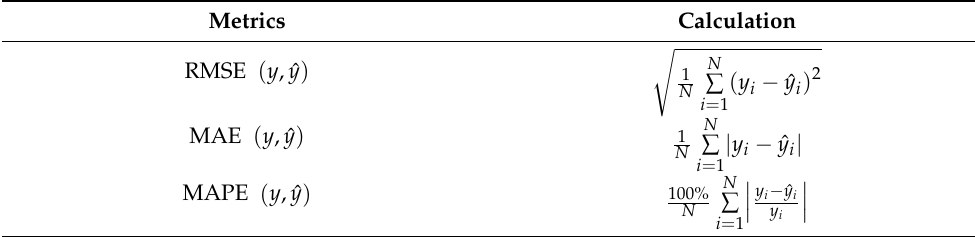
Table 4. Regression prediction performance